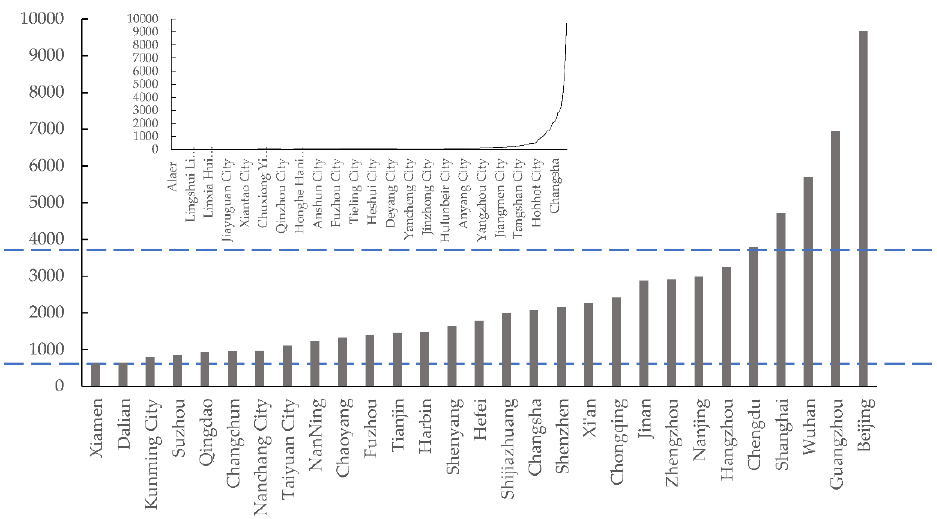
Figure 2. Number of urban microblogging